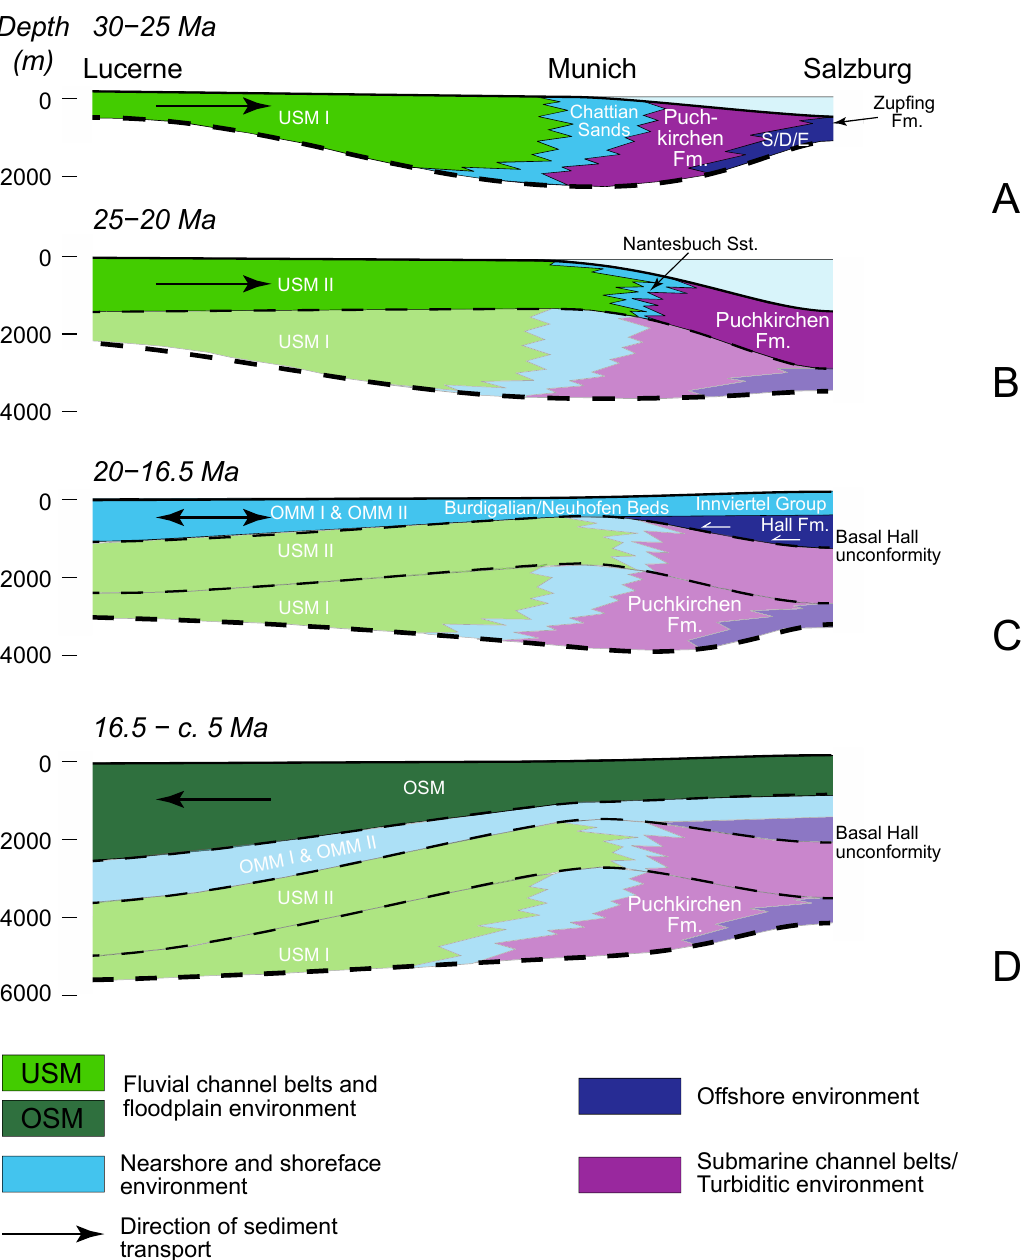
Figure 10. Subsidence of the Molasse basin for a section along the topographic axis. ( A ) Situation between 30 and 25 Ma. This was the time when the sediments of the USM I (lower part of the Lower